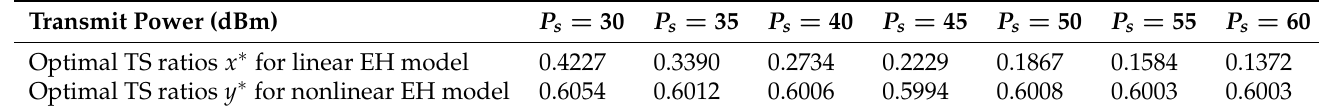
Table 1. Optimal TS ratios for linear and nonlinear EH